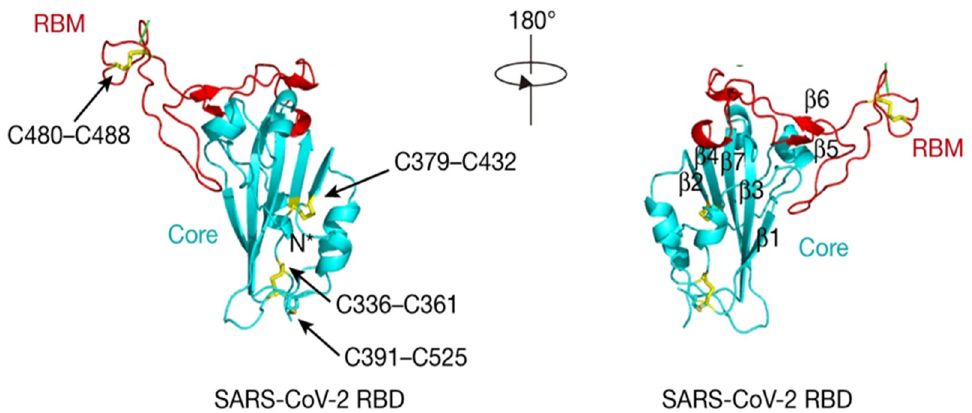
Figure 1. The three-dimensional structure of the receptor-binding domain (RBD) of the SARS-CoV-2 spike (S) glycoprotein. The RBD is shown in cyan, and the receptor-binding motif (RBM) of this protein, which interacts with the cell receptor, is shown in red. The SARS-CoV-2 RBD disulfide bonds are shown in yellow and marked with arrows. Adapted with permission from ref. [13]. Copyright 2020